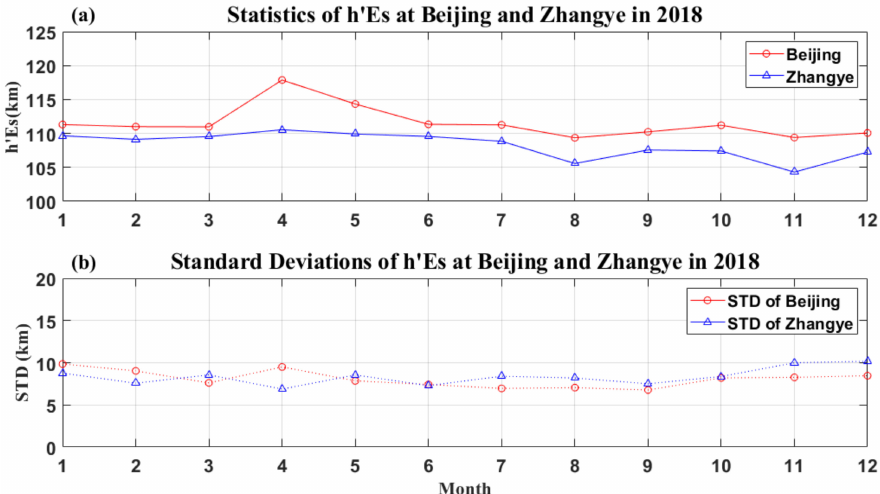
Figure 8. Seasonal changes in mean values ( a ) and standard deviations ( b ) of h’Es at Beijing and Zhangye